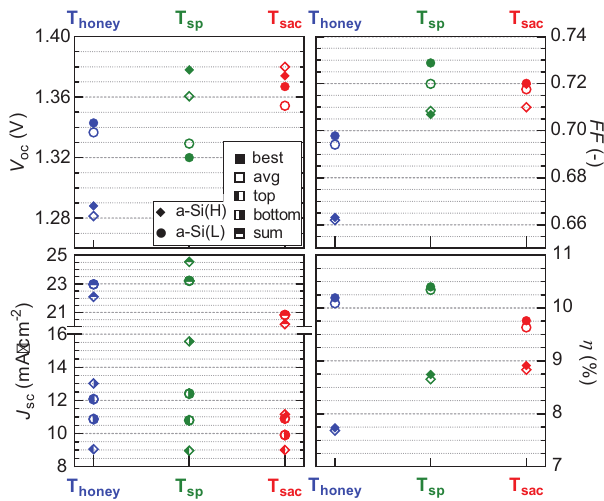
Fig. 12. Solar cell characteristics of a-Si/nc-Si tandem devices as a function of substrate texture. Symbols indicate the character- istics of the best (closed) and average of best 5 (open) cells on a substrate, based on conversion ef fi ciency. Symbol type indicates results of devices with high- E G a-Si (diamond) and low- E G a-Si (circle). J sc is obtained from EQE -measurements and is presented separately for the bottom nc-Si junction, top a-Si junction and sum of both